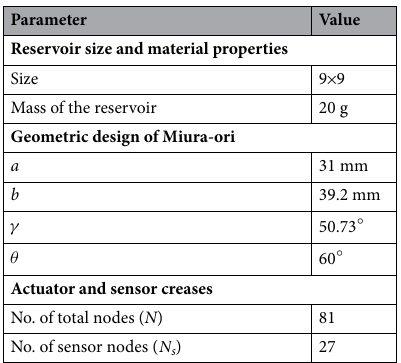
Table 4. Design of the origami reservoir in the emulation task